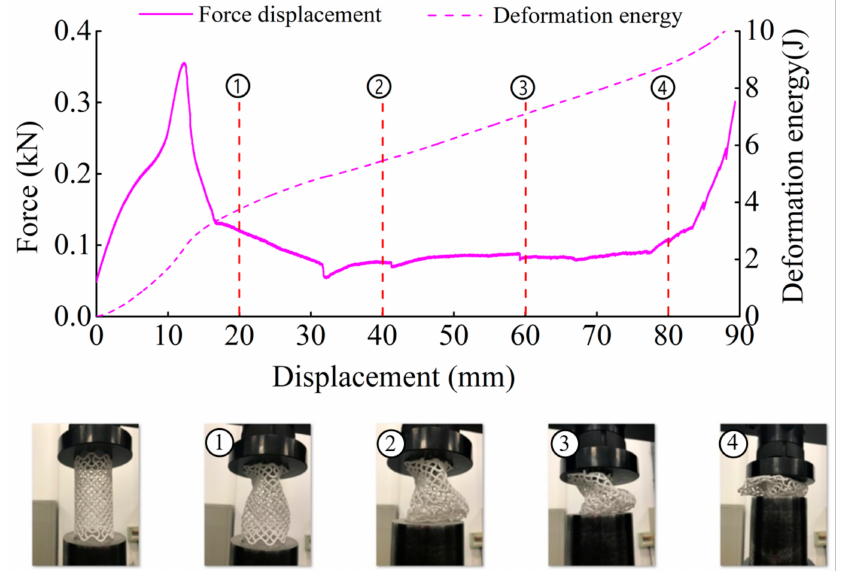
Figure 9. Deformation process of CCHT3 (1–4 stages of deformation during quasi-static compression